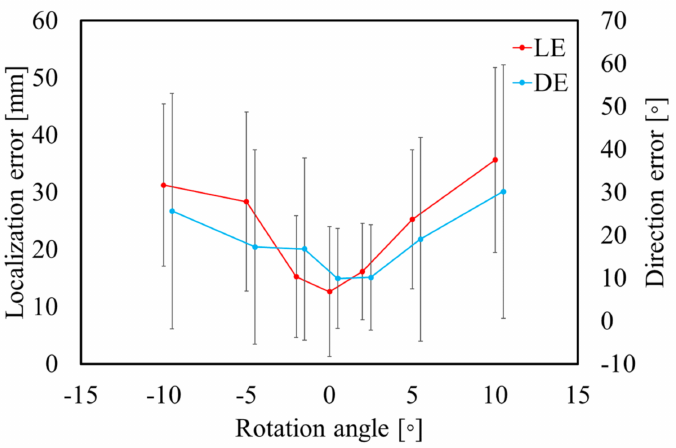
Figure 11. Variability of estimation accuracy for each scaling of heart with SNR = ∞ . Error bars represent standard deviation over 100 test